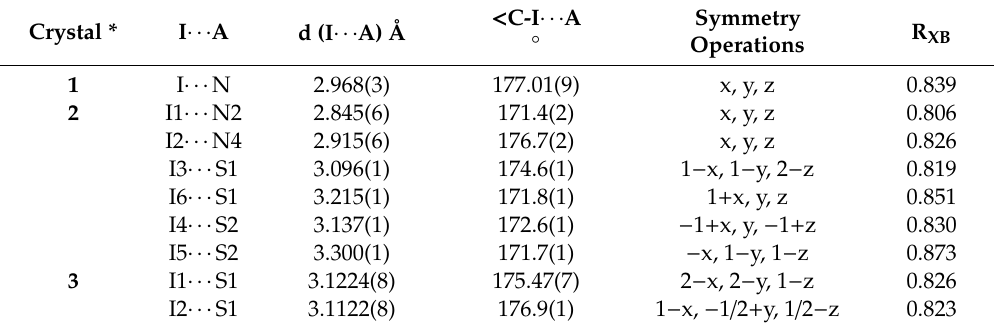
Table 3. Halogen bonds in 1–3.